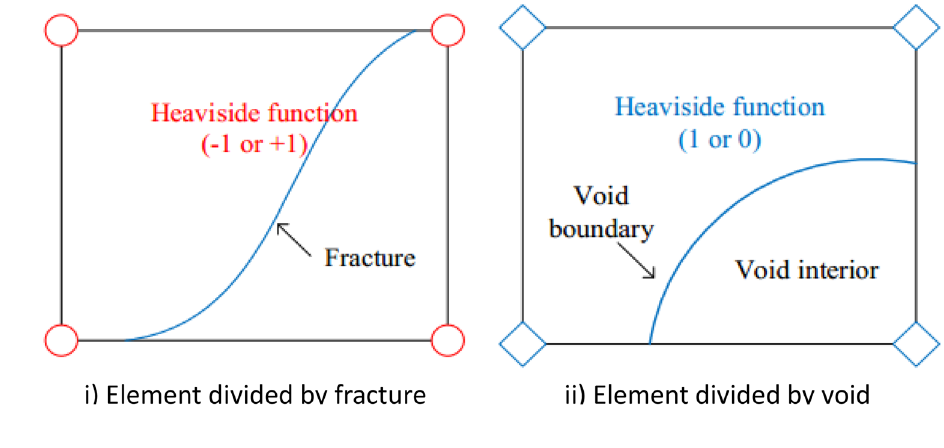
Fig. 3 Junction function and branch function (Youn